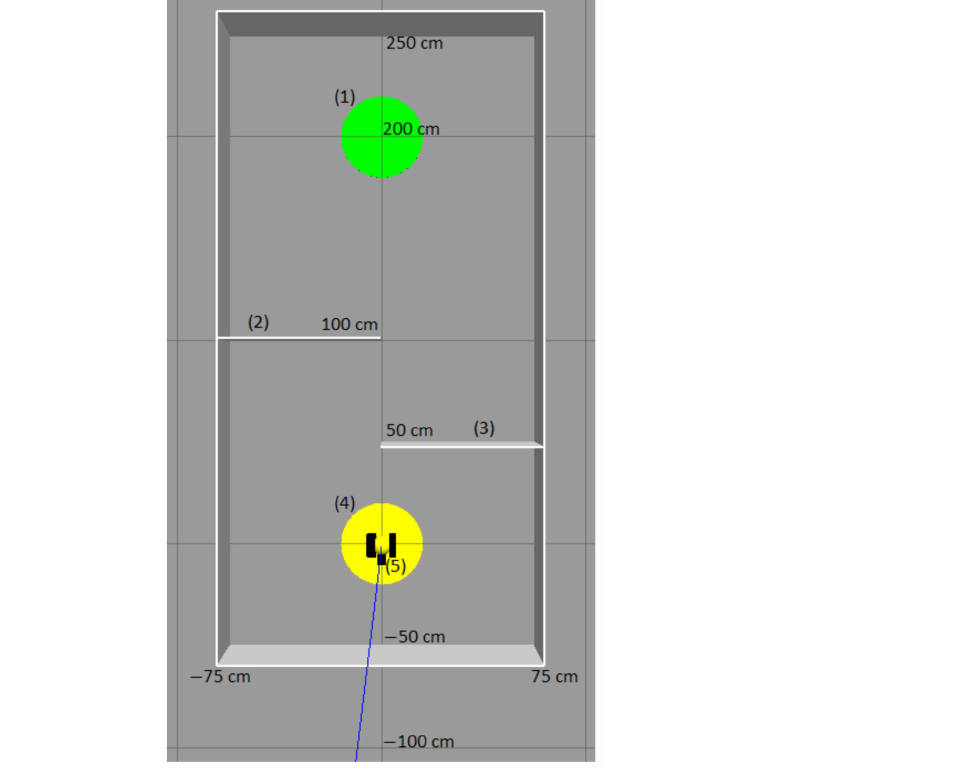
Figure 16. Simulation of labyrinth with two obstacles: (1) goal, (2,3) obstacles, (4) home, and (5) robot. We can observe the physical representation of the maze with two obstacles in Figure 17.